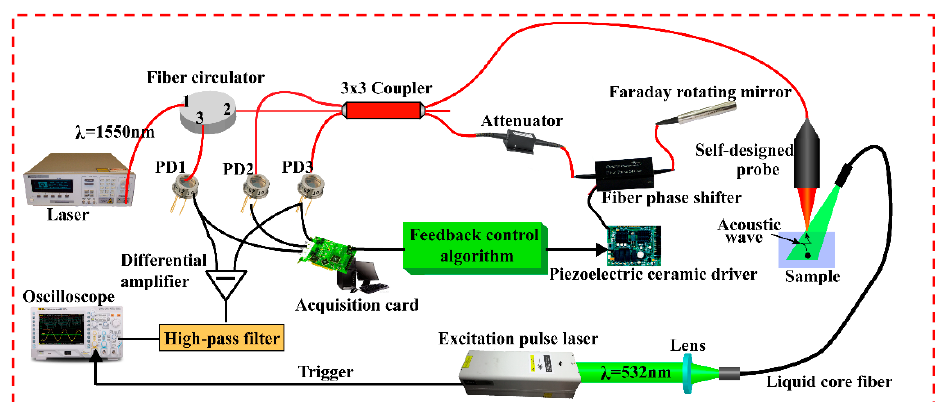
Figure 8. The experimental system of the application of the photoacoustic detection.